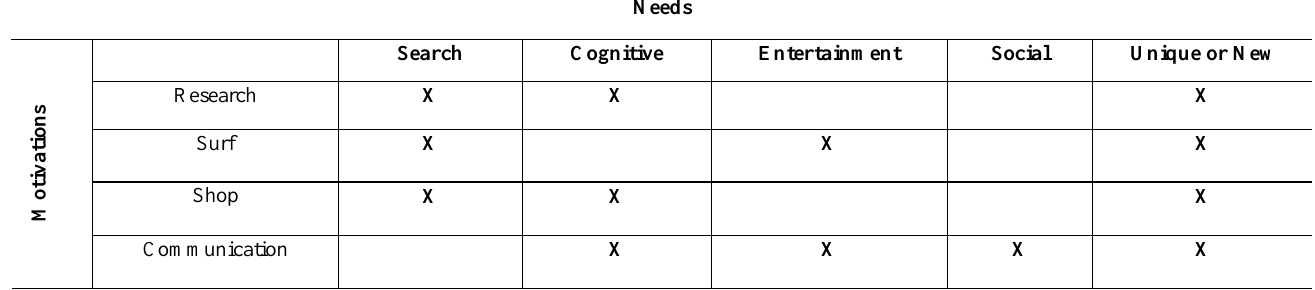
Table 1: Matching needs and motivations